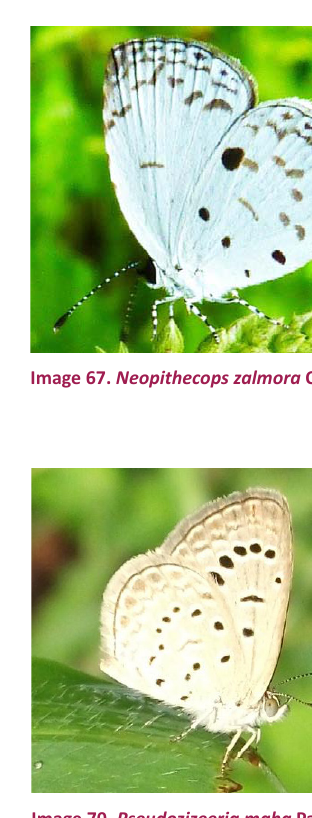
Image 70. Pseudozizeeria maha Pale grass blue